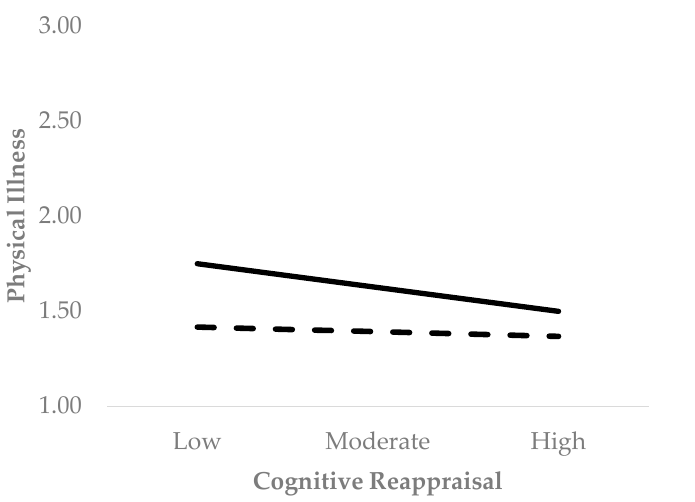
Figure 3. Adaptive upregulation of positive emotions predicting physical illness as a function of gender. Figure 4. Cognitive reappraisal predicting physical illness as a function of Figure 4. Cognitive reappraisal predicting physical illness as a function of gender.